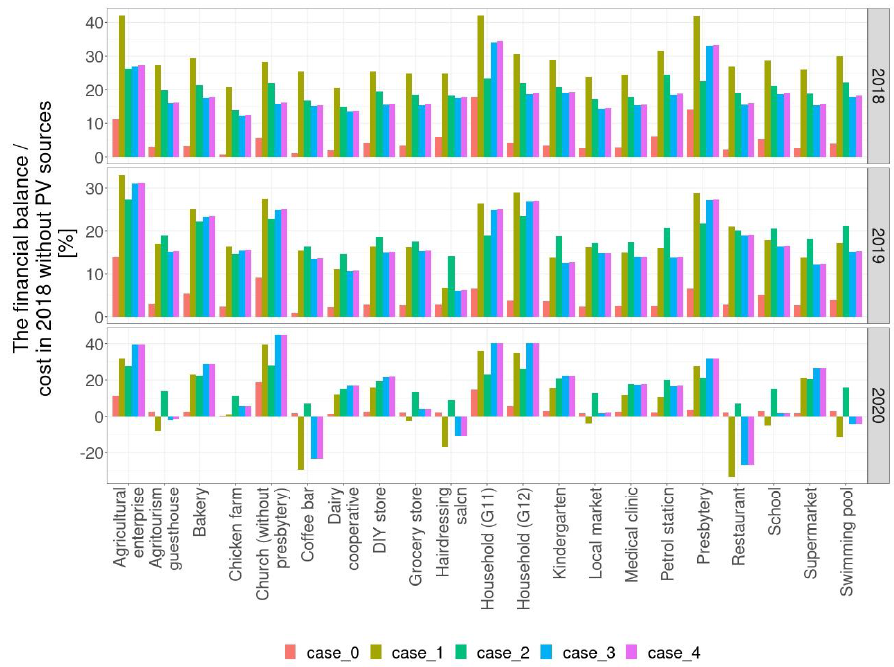
Figure 11. Share of the averaged balance of energy purchase costs by individual prosumers for each year in the 2018–2020 period in relation to the energy purchase costs in 2018 prior to obtaining prosumer status.